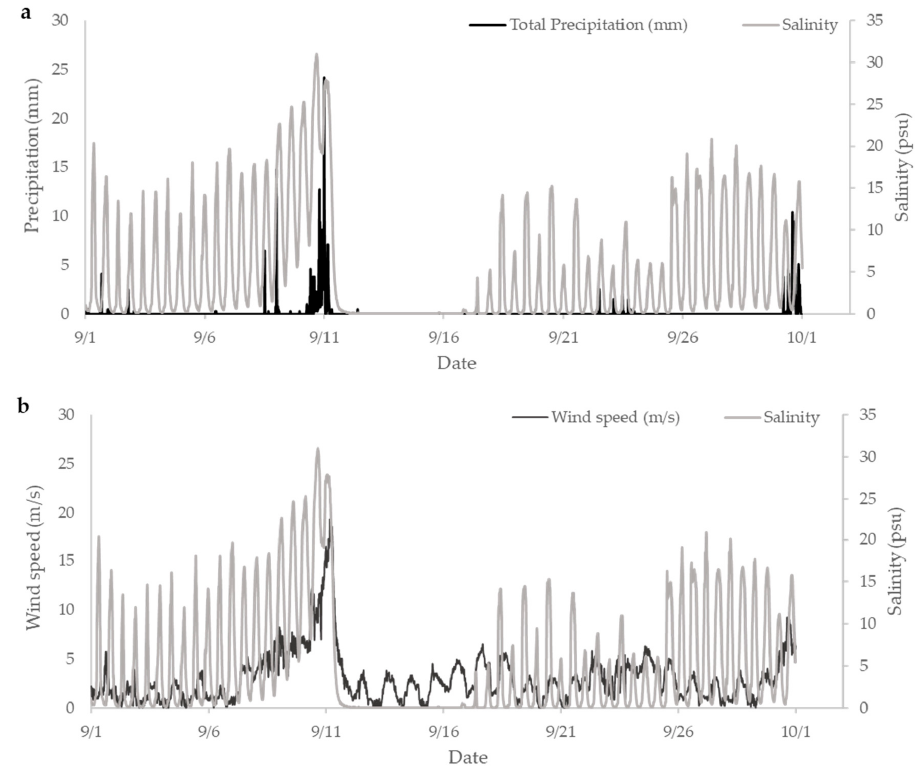
Figure 2. Wind speed ( a ) and precipitation ( b ) measurements taken during the month of September at the middle reaches site and the e ff ects on salinity concentrations within the study site. The spike in precipitation and wind speed indicates the time of impact from Hurricane Irma on the study